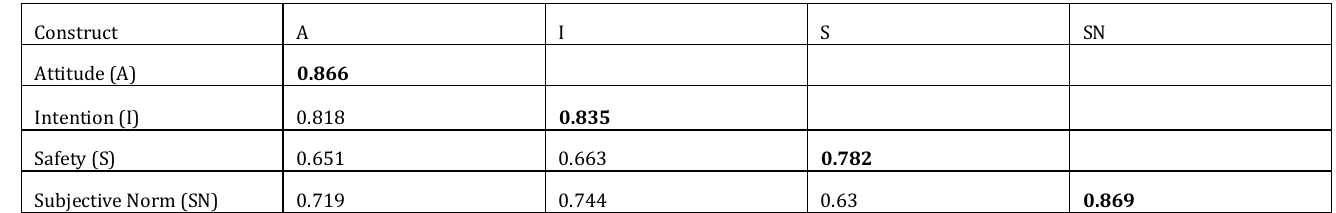
Table 2: Discriminant